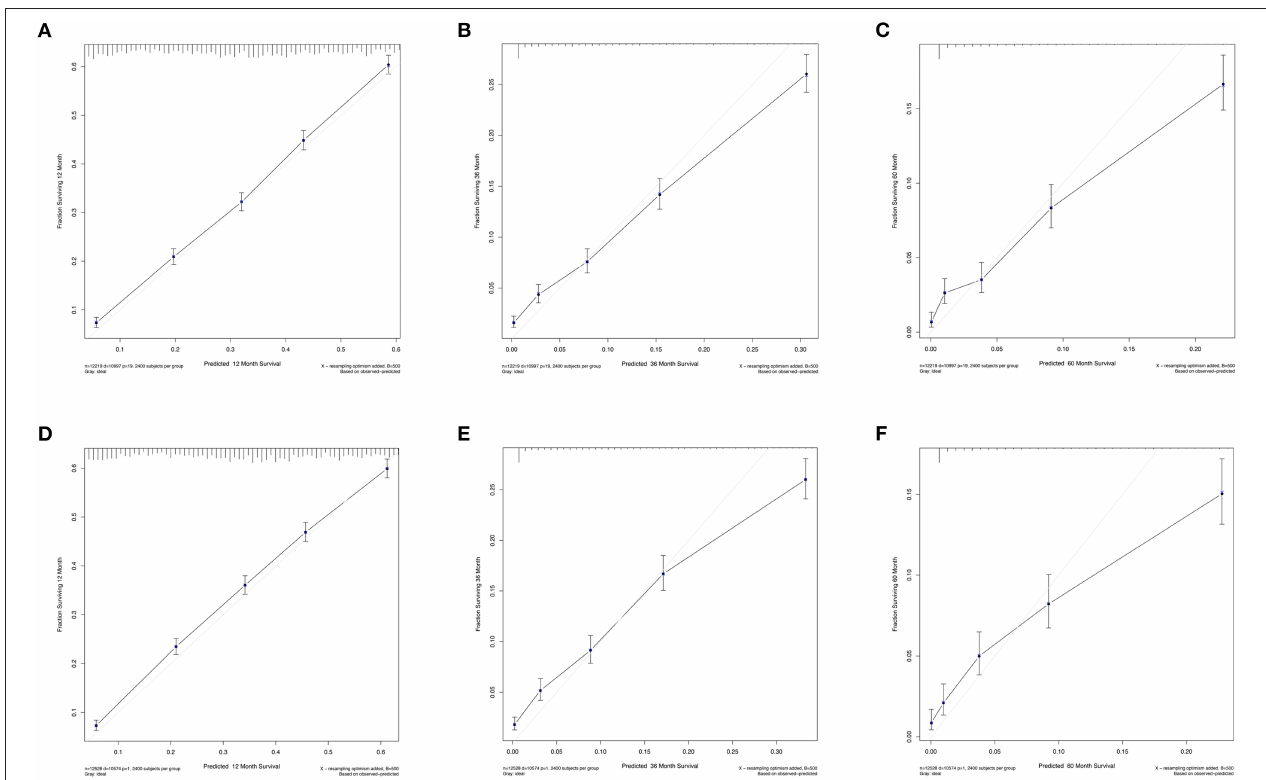
FIGURE 4 | Calibration curves for the nomogram model of predicting 1-year (A,D) , 3-year (B,E) , and 5-year (C,F) OS in patients with N3-NSCLC. (A–C) Internal validation using the training cohort. (D–F) External validation using the validation cohort.